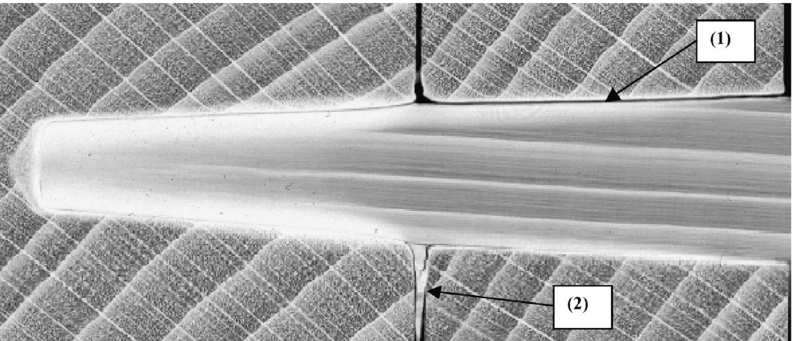
Figure 6. X-ray micrograph of a rotary-welded dowel of beech inserted in beech blocks. The white regions around the dowel correspond to high degree of densification of the welded bond-line; (1) welding has not occurred, or the bond-line has been damaged during the welding; (2) Molten intercellular material which has seeped into the fissure between the two blocks [24,49].